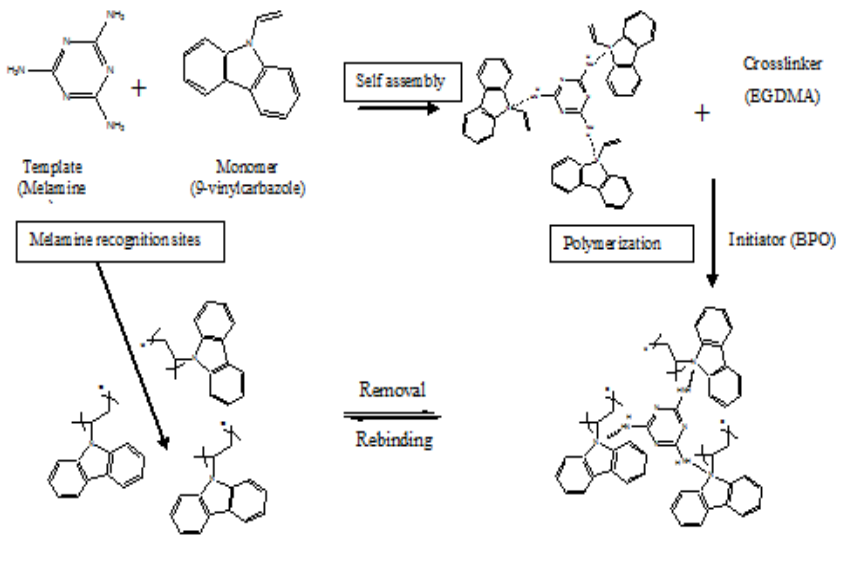
Figure 2. Proposed interaction between monomer (9-vinylcarbazole) and the template